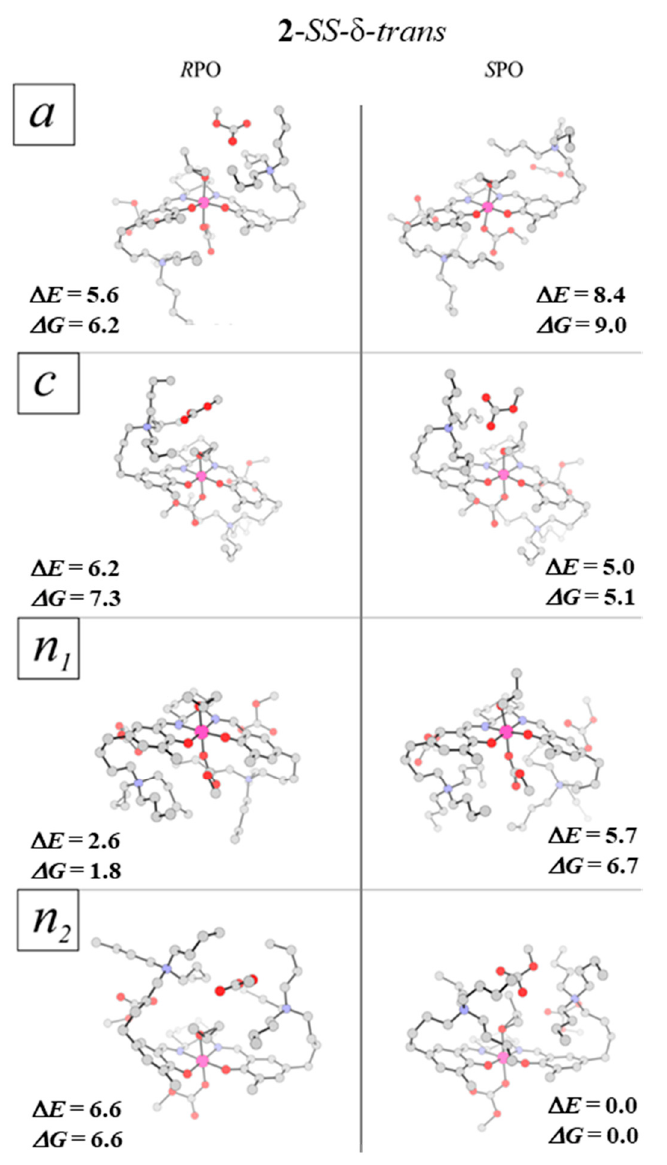
Figure 10. The lowest-energy R PO and S PO complexes within each group of a , c , n1 , and n2 isomers of 2 - SS - δ - trans system. The relative electronic-energy and free-energy values ( ∆ E and ∆ G in kcal/mol, see also Table 3) calculated with respect to the “global minimum” structure, 2 - SS - δ - trans - n2 - S PO. Hydrogen atoms are not shown for clarity.